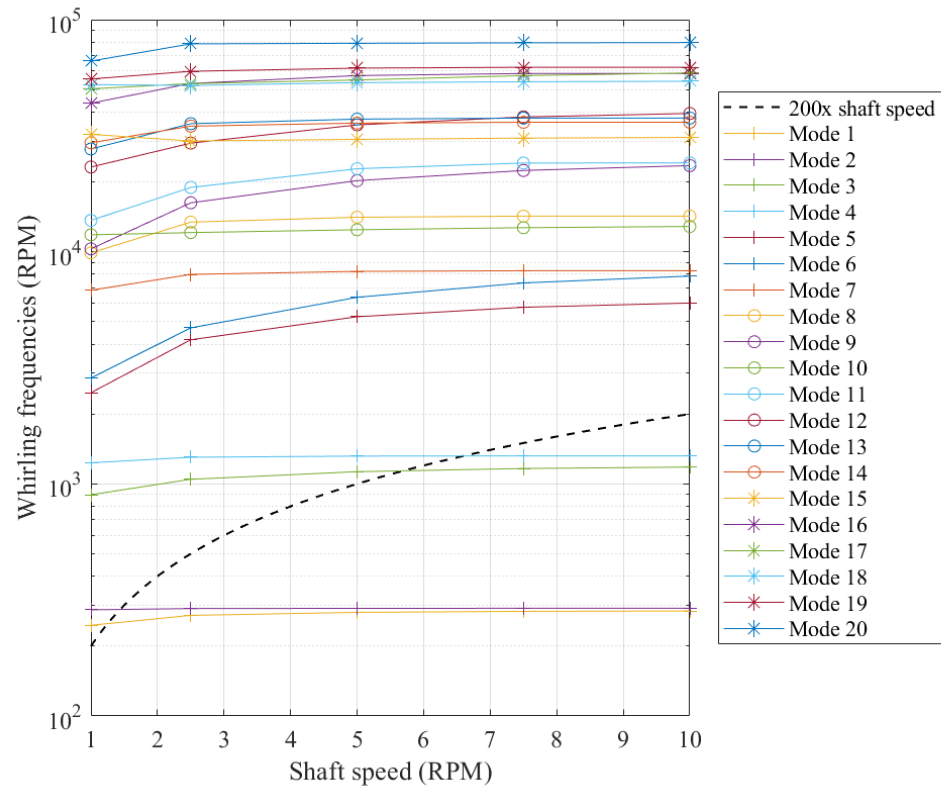
Figure 6. Campbell diagram. Several modes show frequency-crossing events. The black dashed line corresponds to 200 p excitation. This figure was generated using the speed-dependent eigenmode method described in Section 2.3. This figure shows how the algorithm captured multiple frequencies crossing each other.